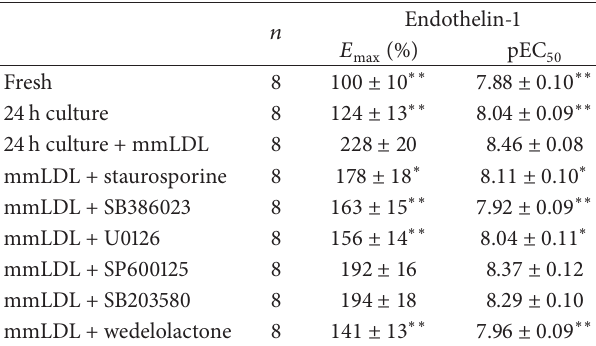
Figure 1: Culturing with mmLDL enhanced the ET-1-induced contraction of rat coronary artery segments. (a) The concentration-dependent effect of culturing with mmLDL for 24h; ∗ 𝑃 < 0.05 , ∗∗ 𝑃 < 0.01 versus organ culture for 24 h; ## 𝑃 < 0.01 versus 5 𝜇 g/mL of mmLDL for 24 h. (b) The time-dependent effect of culturing with 10 𝜇 g/mL of mmLDL. 󳶚 𝑃 < 0.05 , 󳶚󳶚 𝑃 < 0.01 versus 10 𝜇 g/mL of mmLDL for 12h. The data are presented as the mean ± SEM. 𝑛 = 8 coronary arteries, from that number of animals. Table 1: Contractile effects of endothelin-1 (ET-1) in coronary